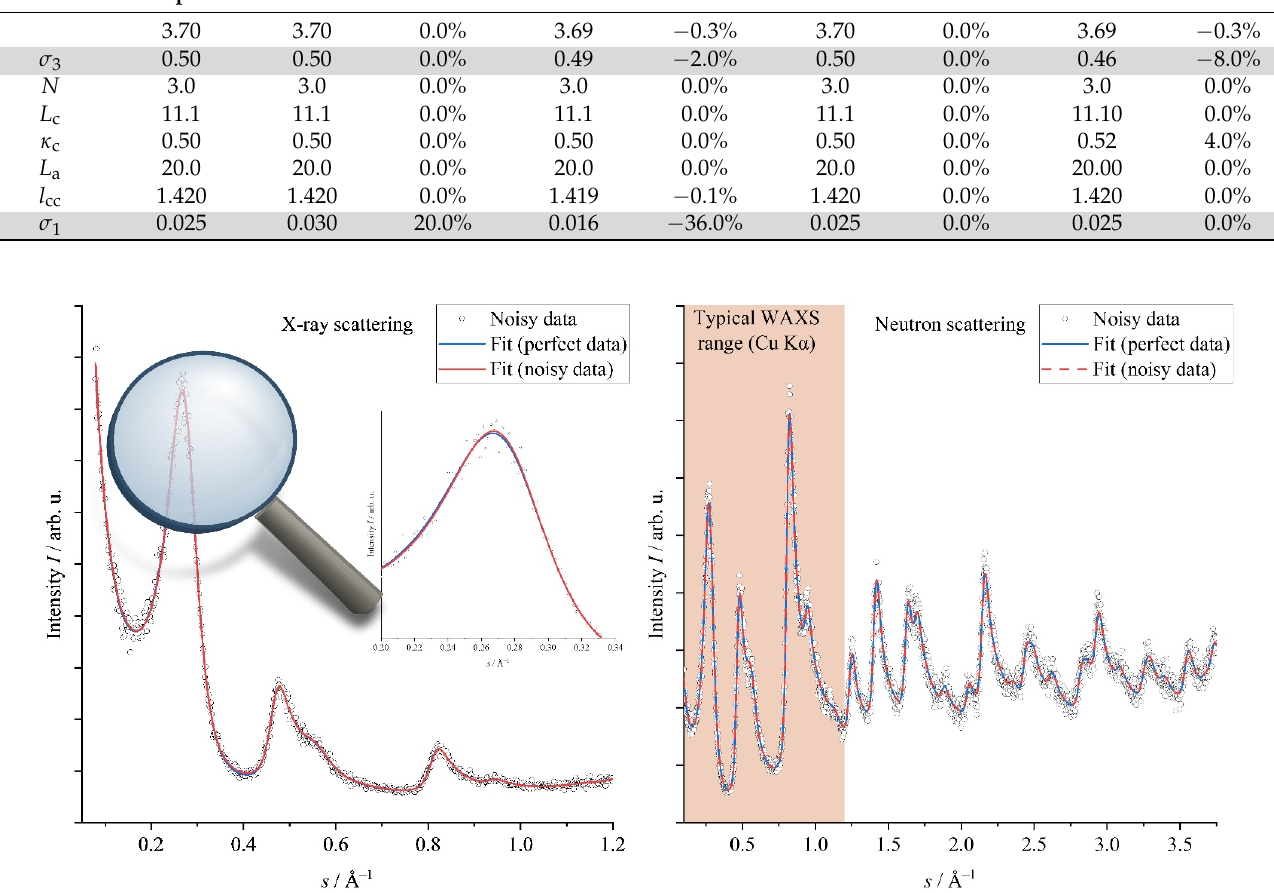
Figure 8. Noise level test using simulated WAXS (left) and WANS (right) data, which were blurred by statistical noise according to a Gaussian distribution ( σ = 0.05) (black). The range of s values and the used noise level correspond to that of a typical laboratory instrument using Cu K α radiation, especially for WAXS. The resulting fit of the noised data (red) is close to the fit for the perfect data (blue). The deviations are only small, implying that such noise level does not exert significant influence on the resulting structural parameters (Table 4). The data are simulated corresponding to a resin treated at medium heat-treatment temperatures (1800–2500 ◦ C) or a pitch at lower